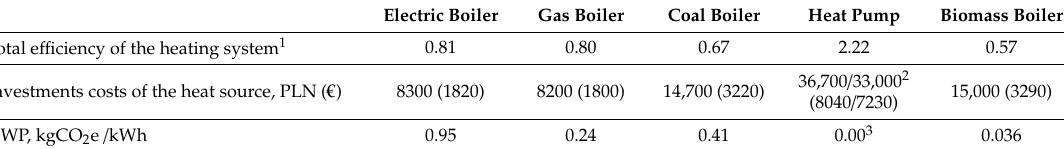
Table 3. Data for the heat